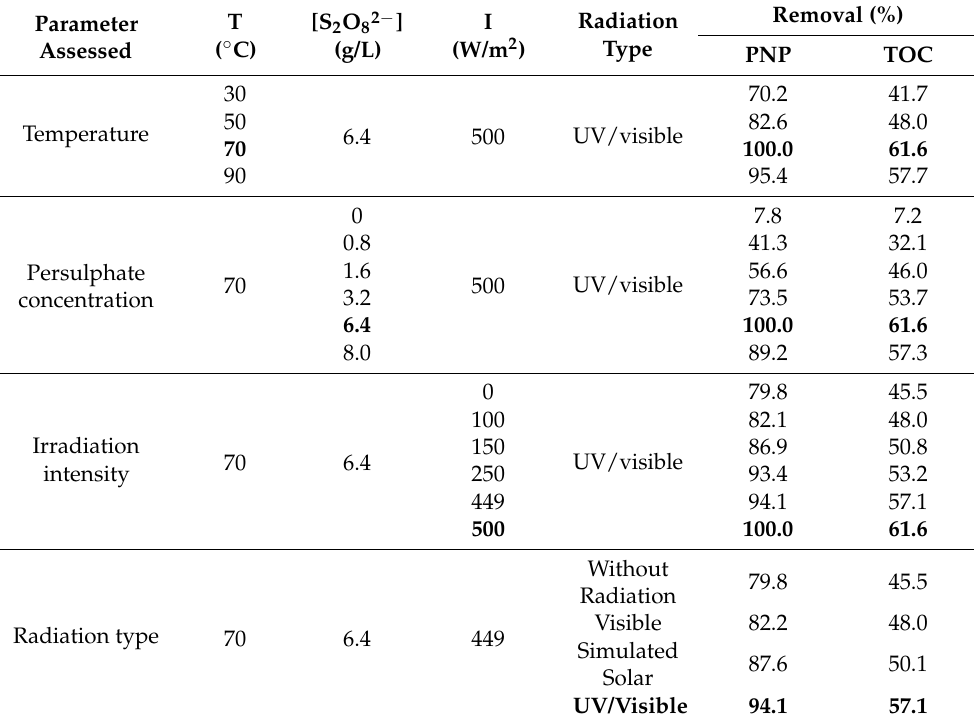
Table 2. Conditions employed in the activated persulphate process and PNP and TOC removals after 2 h. In bold are highlighted the optimum conditions in each set of the parametric